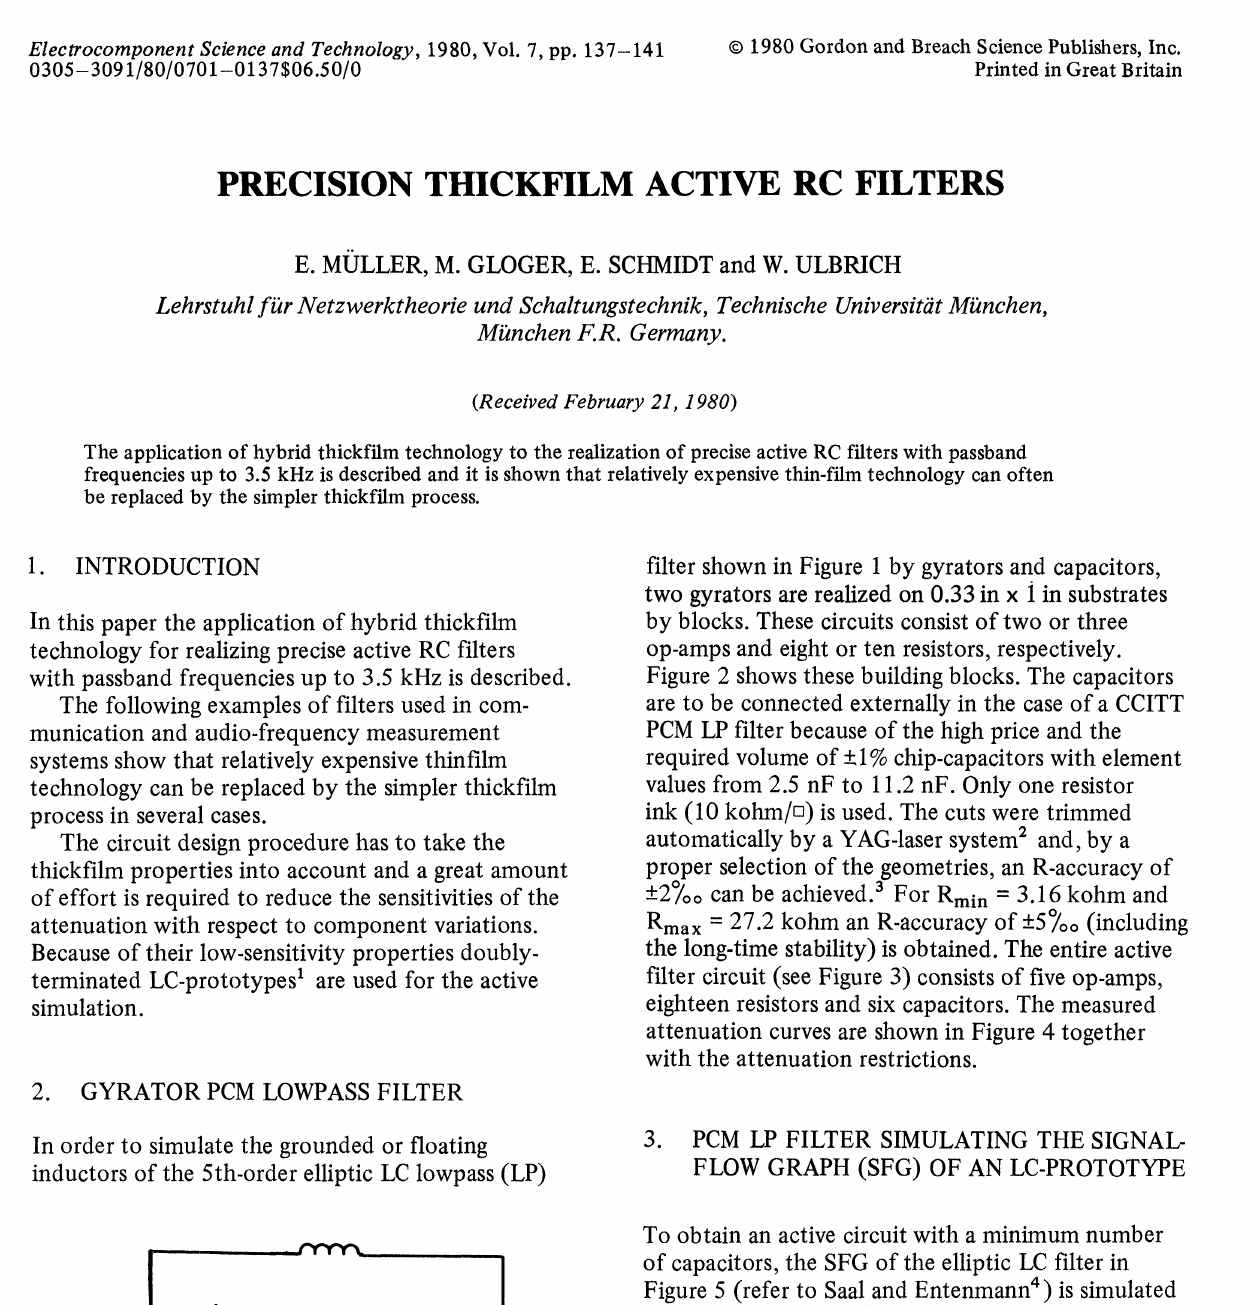
FIGURE LC-prototype for the gyrator PCM LP filter.